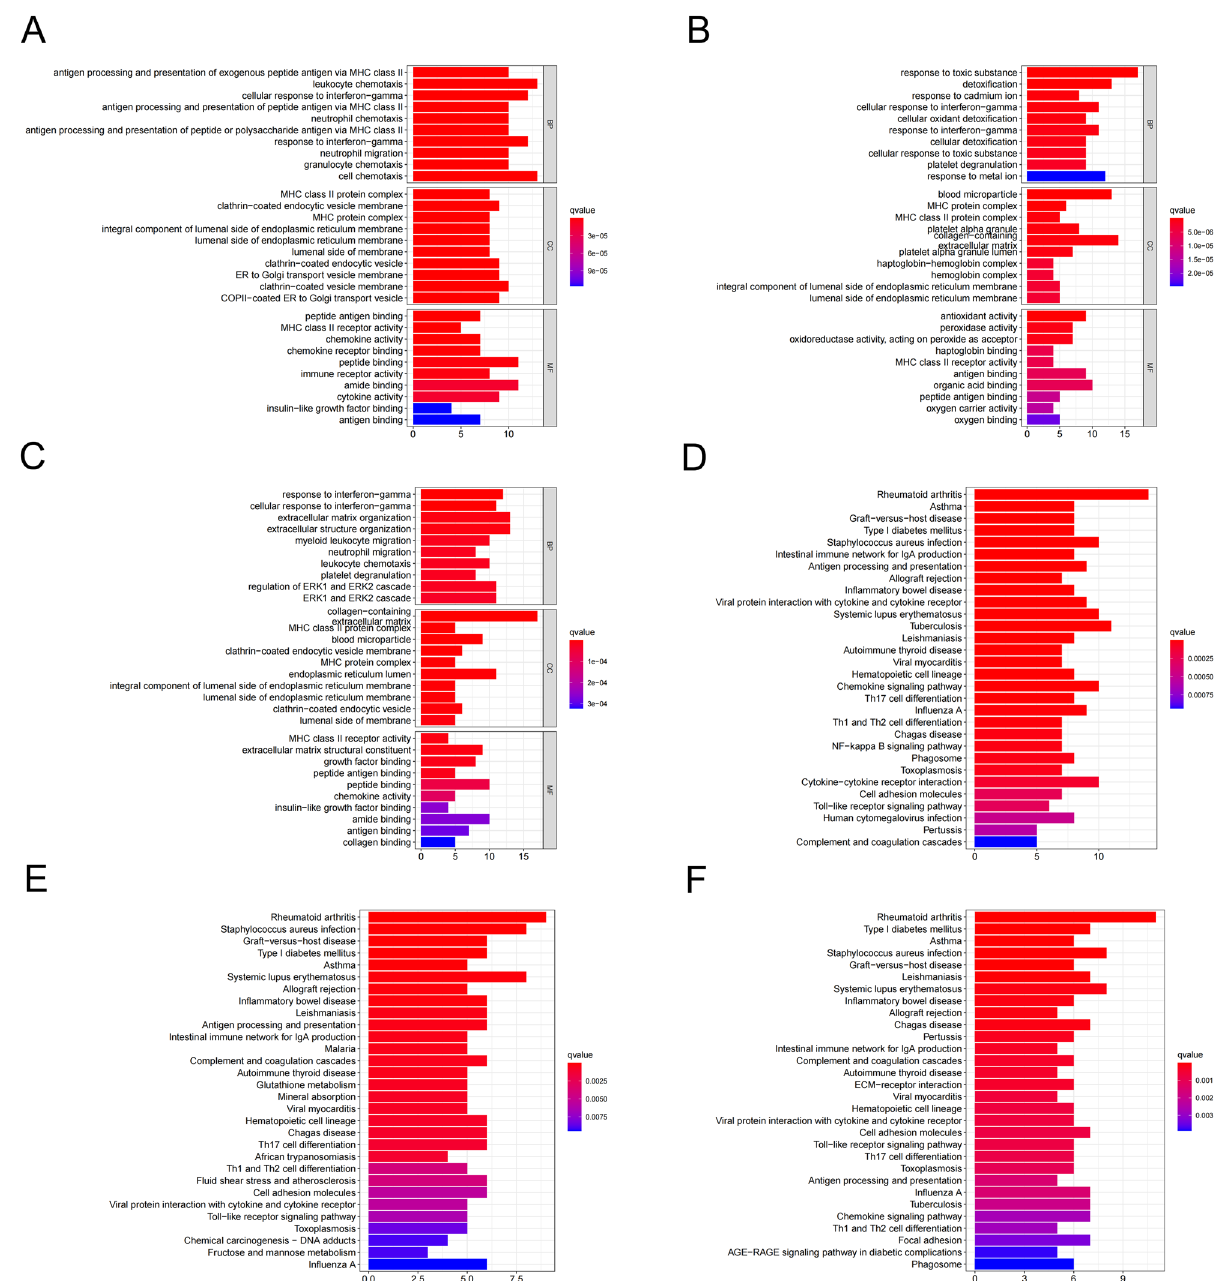
Figure 3. GO and KEGG enrichment analyses of DRGs in three subsets. ( A–C ) GO functional analysis of DRGs in subsets I-III. ( D–F ) KEGG pathway enrichment analysis of DRGs in subsets